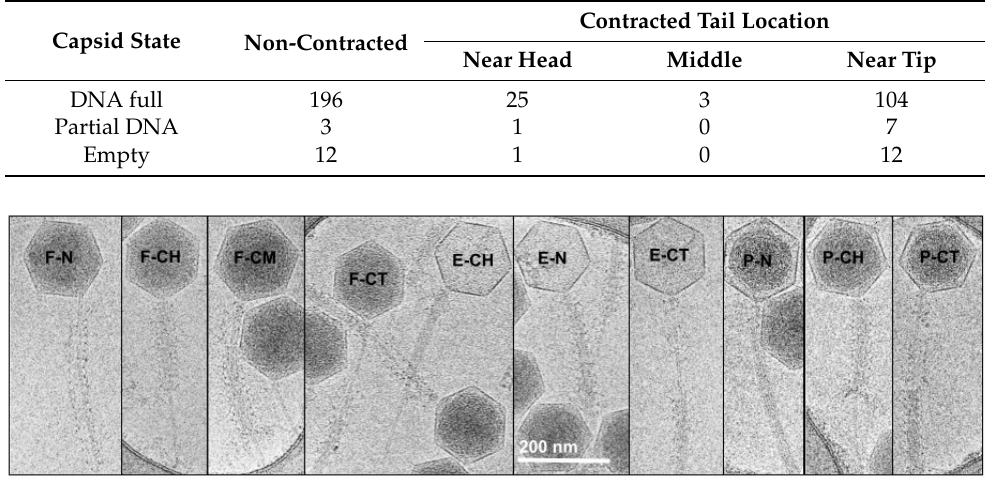
Figure 2. Representative members of cryo-EM-based categories of purified phage G. Particles are labeled as follows: F—DNA full; P—partial DNA; E—empty; N—non-contracted; CH—contracted near head; CM—contracted middle; CT—contracted at tip, as shown by the representative images. Table 1. Tail contraction and head states from cryo-EM micrographs.